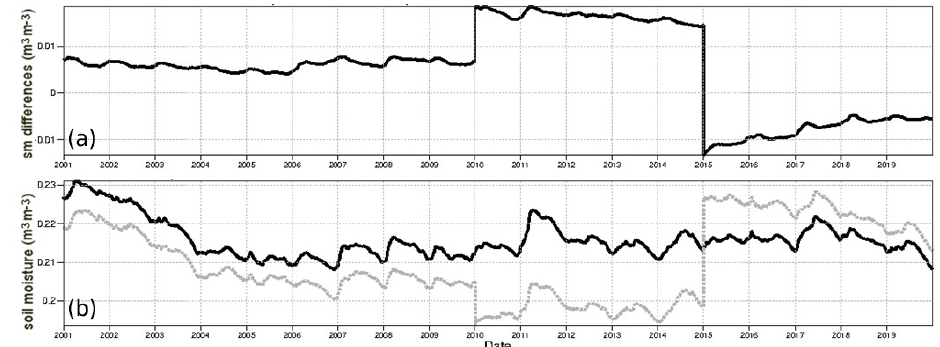
Figure 3. (a) Mean differences between ERA5-Land and ERA5 soil moisture (sm) time series for the fourth soil layer of the Carbon Hydrology-Tiled ECMWF Scheme for Surface Exchanges over Land (CHTESSEL) land surface model (100–289cm), averaged for the latitudes 60–20 ◦ S. The temporal resolution is 12h. Panel (b) is the same as (a) but showing the raw time series of ERA5 (dashed light grey curve) and ERA5-Land (dark